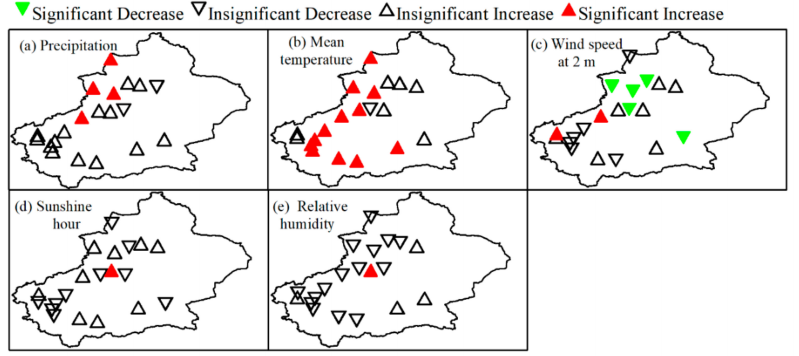
Figure 3. The spatial distribution of the trends and significance of the selected climatic variables during the winter wheat-growing season in 1981–2017. The trends were tested by the MMK method.